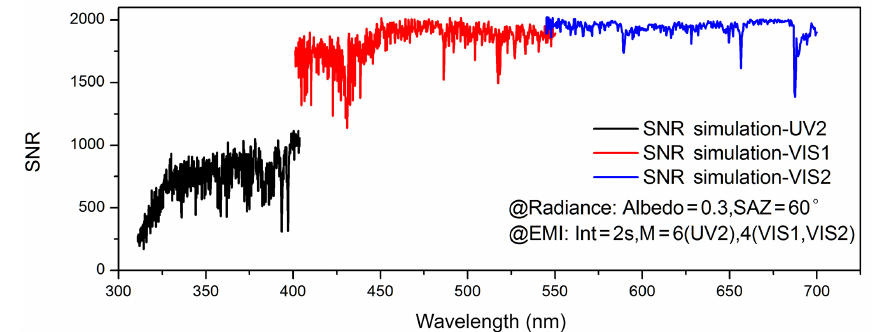
Figure 15. Simulation EMI in-orbit SNR of UV2, VIS1, and VIS2. The input radiance for the SNR model is obtained by MODTRAN with an albedo of 0.3 and with the sun zenith at 60 ◦ . The EMI simulation SNR has an integration time of 2s; it has binning factors of 6 for UV 2 channels and 4 for VIS channels. The spectral bandwidth of a pixel was 0.09nm for UV2, 0.12nm for VIS1, and 0.13nm for VIS2.